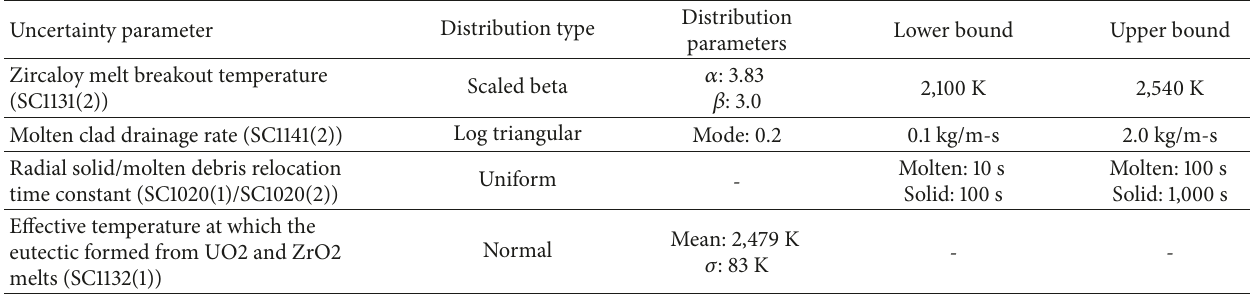
Table 1: The information of PDF about selected uncertainty